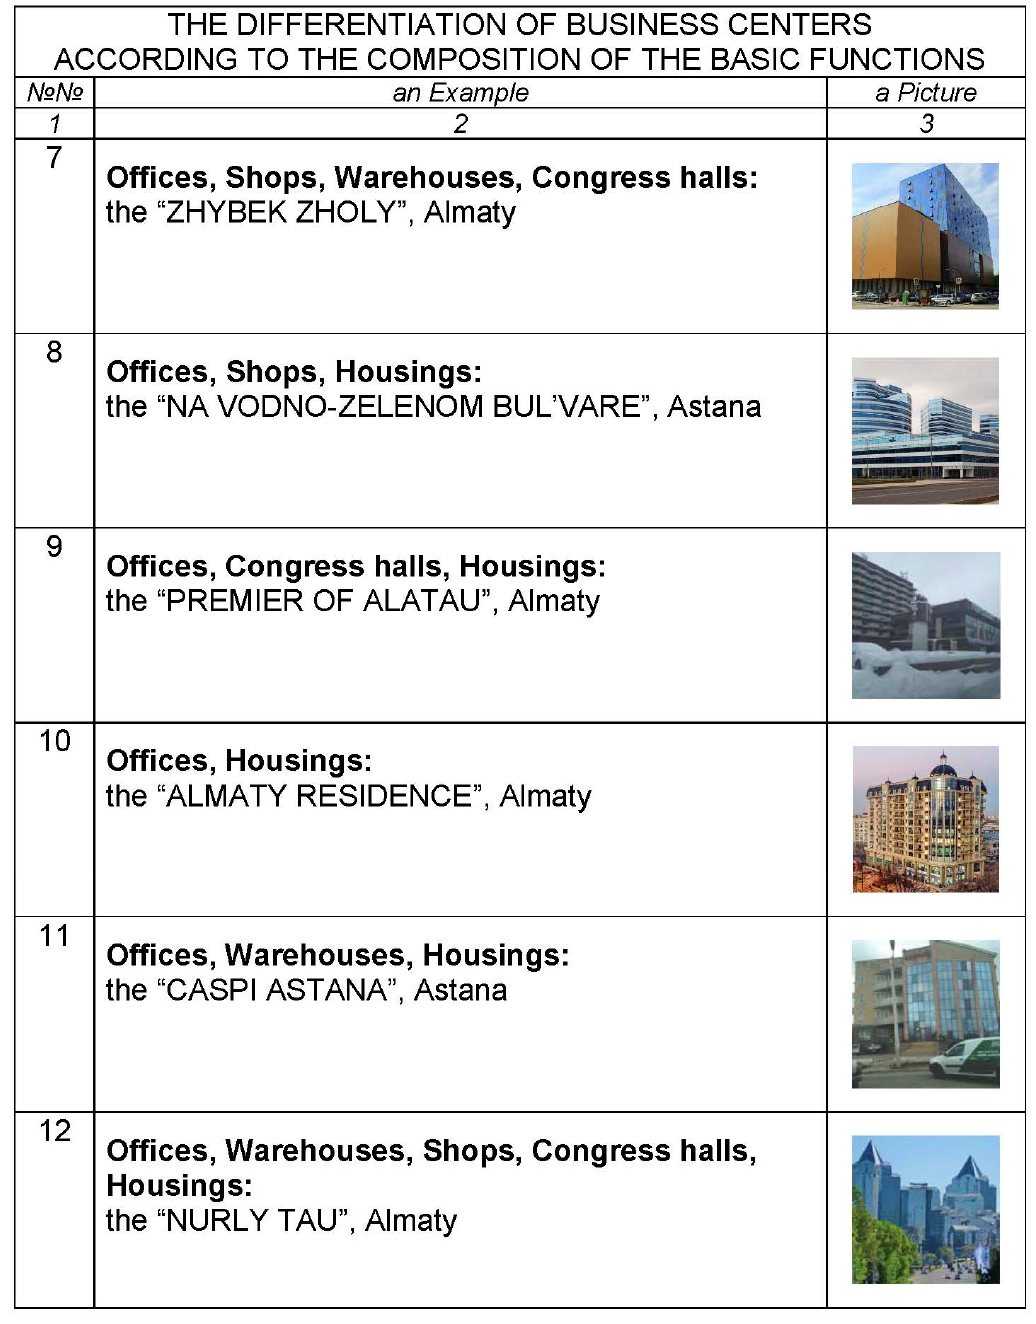
Figure 10. The differentiation of business centers by the composition of basic functions: ( 7 ) the ZHYBEK ZHOLY, Almaty [110]; ( 8 ) the NA VODNO-ZELENOM BUL’VARE, Astana [111]; ( 9 ) the PREMIER OF ALATAU, Almaty [112]; ( 10 ) the ALMATY RESIDENCE, Almaty [113]; ( 11 ) the CASPI ASTANA, Astana [114]; and ( 12 ) the NURLY TAU, Almaty [115]. Moreover, the relative position of these groups of premises is not due to regulatory restrictions, with the exception of sanitary and epidemiological restrictions (e.g., the min- imum height of various types of premises, the inadmissibility of placing sanitary units above residential, working and partially commercial and warehouse premises, the inadmis- sibility of single-level or floor-by-floor proximity of working and residential premises with engineering support systems and elevator shafts, etc.) and fire-evacuation requirements (e.g., the number of exits depending on the number of people arriving in the room at